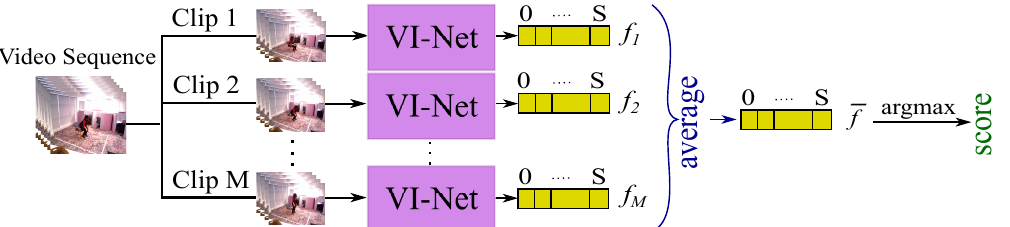
Figure 6. Scoring process for a full video sequence in testing phase.